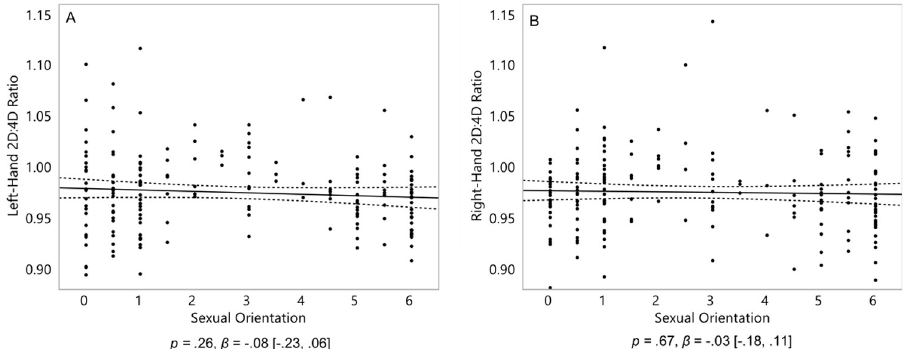
Fig 2. 2D:4D of 182 women (left-hand 2D:4D, A; and right-hand 2D:4D, B). On the Y axis, 2D:4D is the length of the index finger divided by the length of the ring finger, with lower scores representing a more male-typical 2D:4D. On the X axis, 0 represents exclusive heterosexuality, 3 represents bisexuality, and 6 represents exclusive homosexuality. Triple lines represent regression coefficients with their 95% confidence intervals. Dots represent participants’ scores. Statistics represent linear